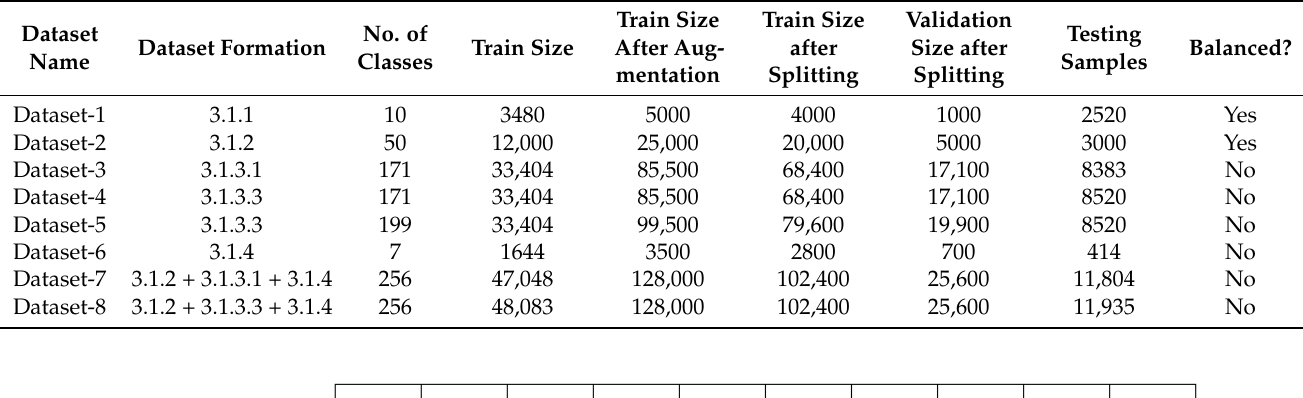
Table 1. Dataset formations, number of classes, number of training, validation, and testing samples, and whether dataset is balanced or imbalanced.